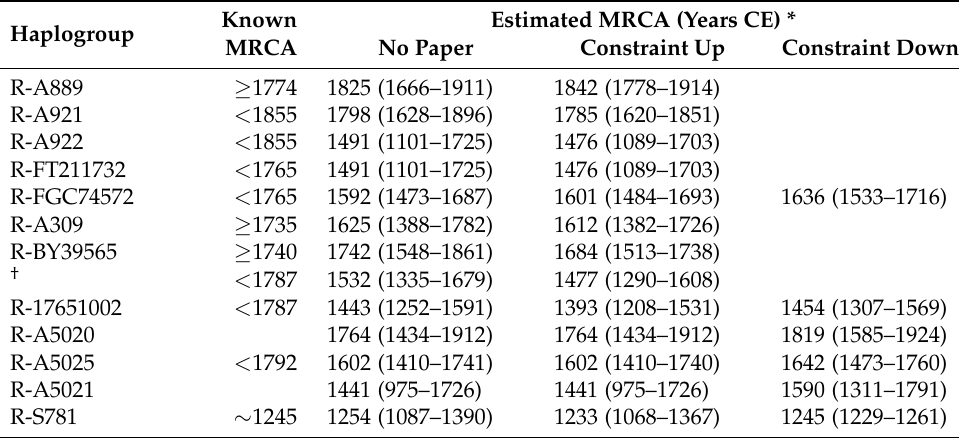
Table 5. Date of MRCA estimates in Example